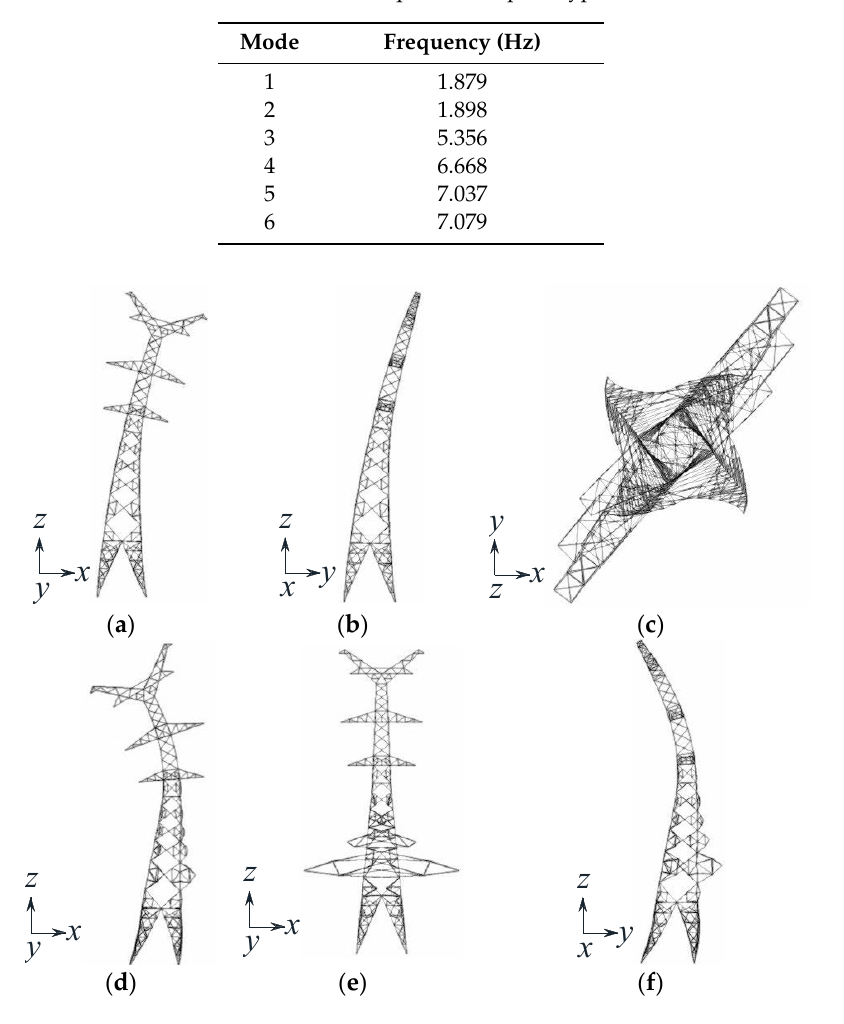
Figure 7. Mode shapes of prototype structure. ( a ) 1st mode; ( b ) 2nd mode; ( c ) 3rd mode; ( d ) 4th mode; ( e ) 5th mode; ( f ) 6th mode.